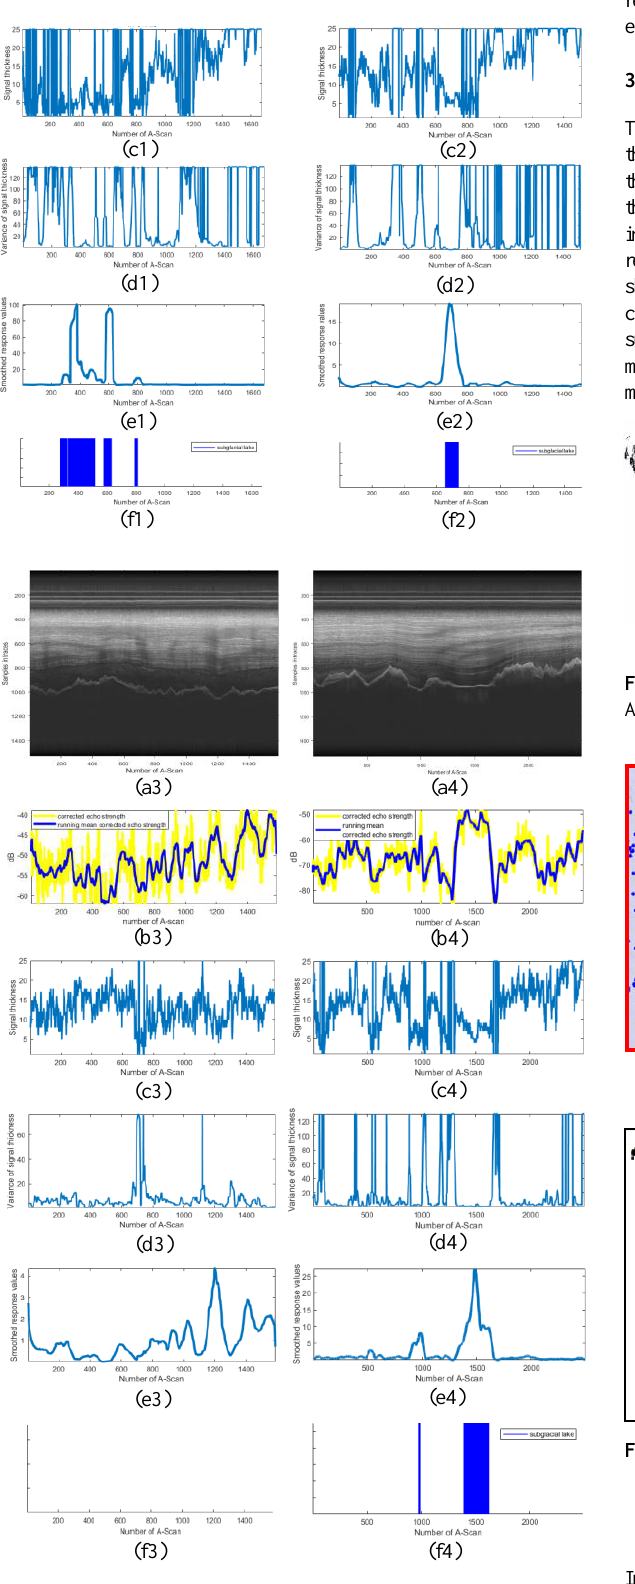
Figure 6 . Relevant experimental results of other echograms. (a1-a4) Radar echograms, (b1-b4) corrected echo strength corresponding to the basal interface, (c1-c4) signal thickness, (d1-d4) variance of the signal thickness, (e1-e4) smoothed